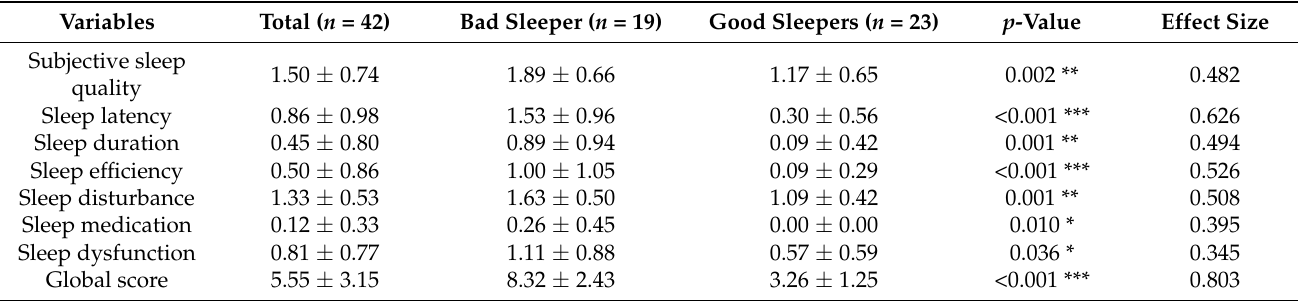
Table 2. Mean global and component PSQI scores (mean ±